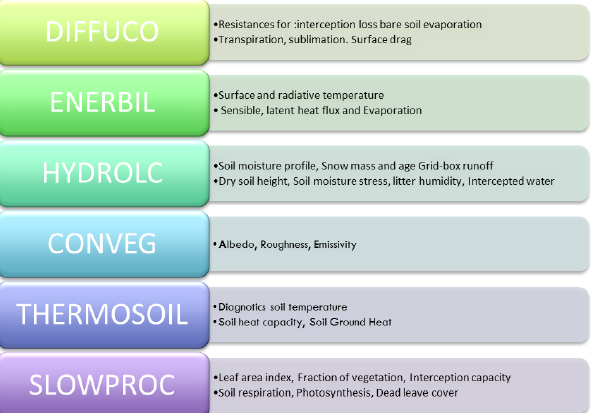
Figure A1. SECHIBA subroutines and their corresponding outputs. Source: Benavides Pinjosovsky (2014).